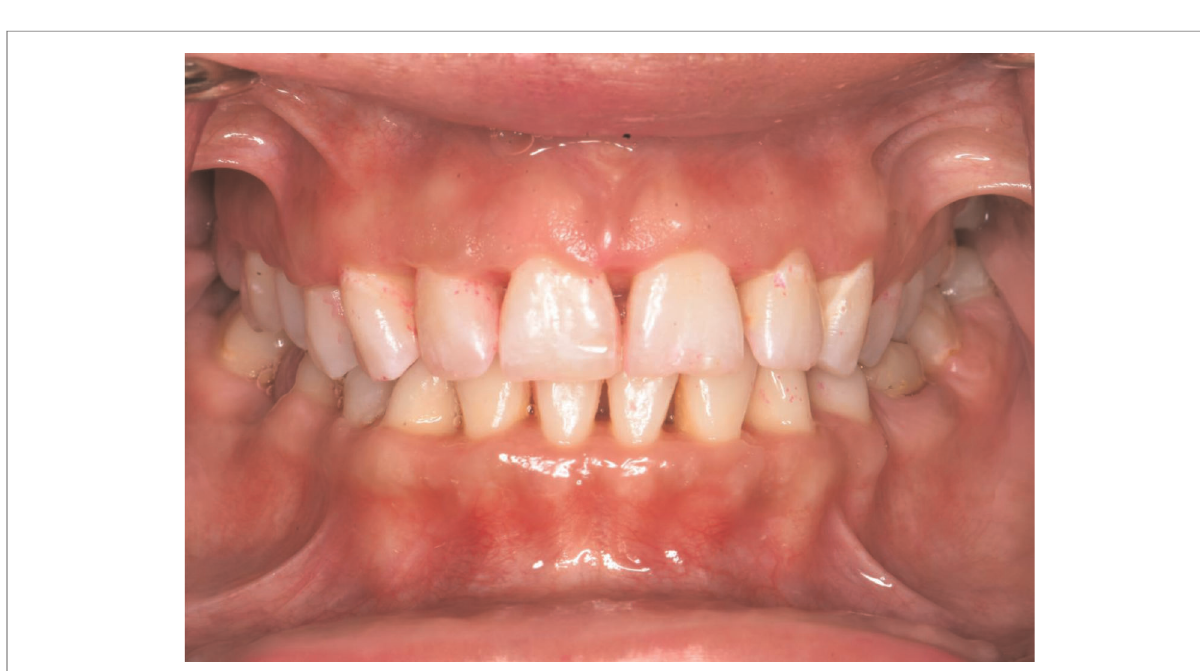
FIGURE 3 Clinical presentation after treatment. Pocket probing depth reduces to 1 – 4 mm after treatment. Necrotized “ punched out ” interdental papillae have healed. Interdental papillae are blunted in the anterior dentition as the patient had nonreversible bone loss. In the posterior area without bone loss, a complete fi ll of the interdental spacing with papillae is